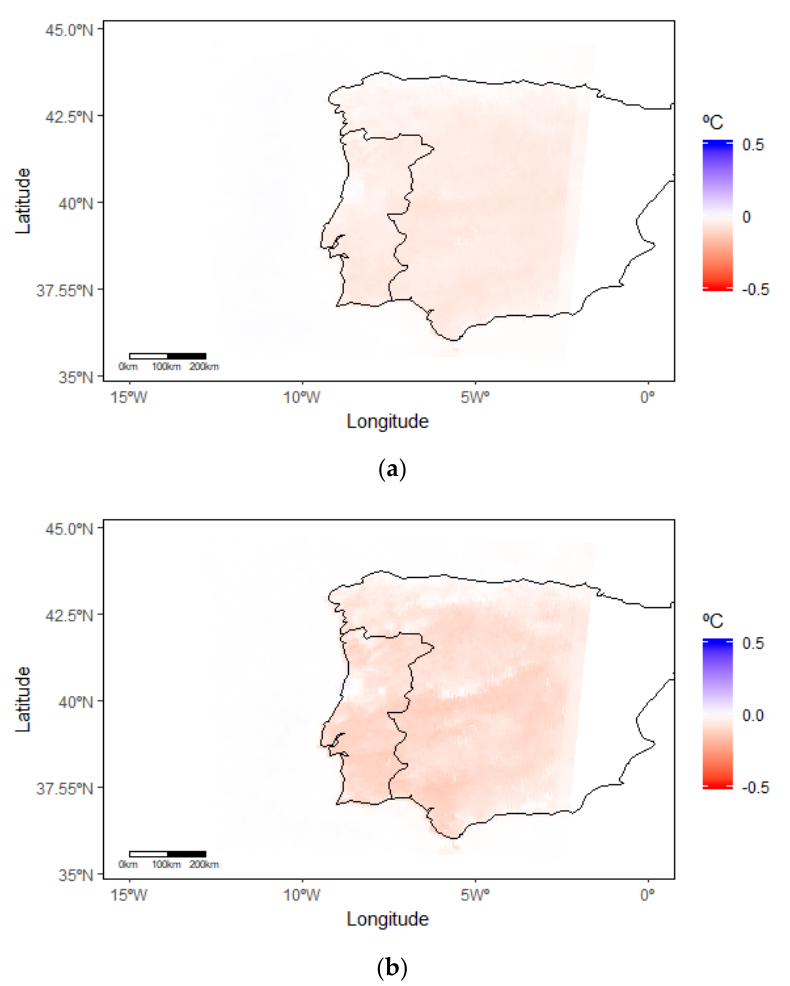
Figure 7. Spatial differences of air temperature comparing both simulations (with feedback and without feedback): ( a ) annual average including all hourly values; and ( b ) annual average of daily maximum values.